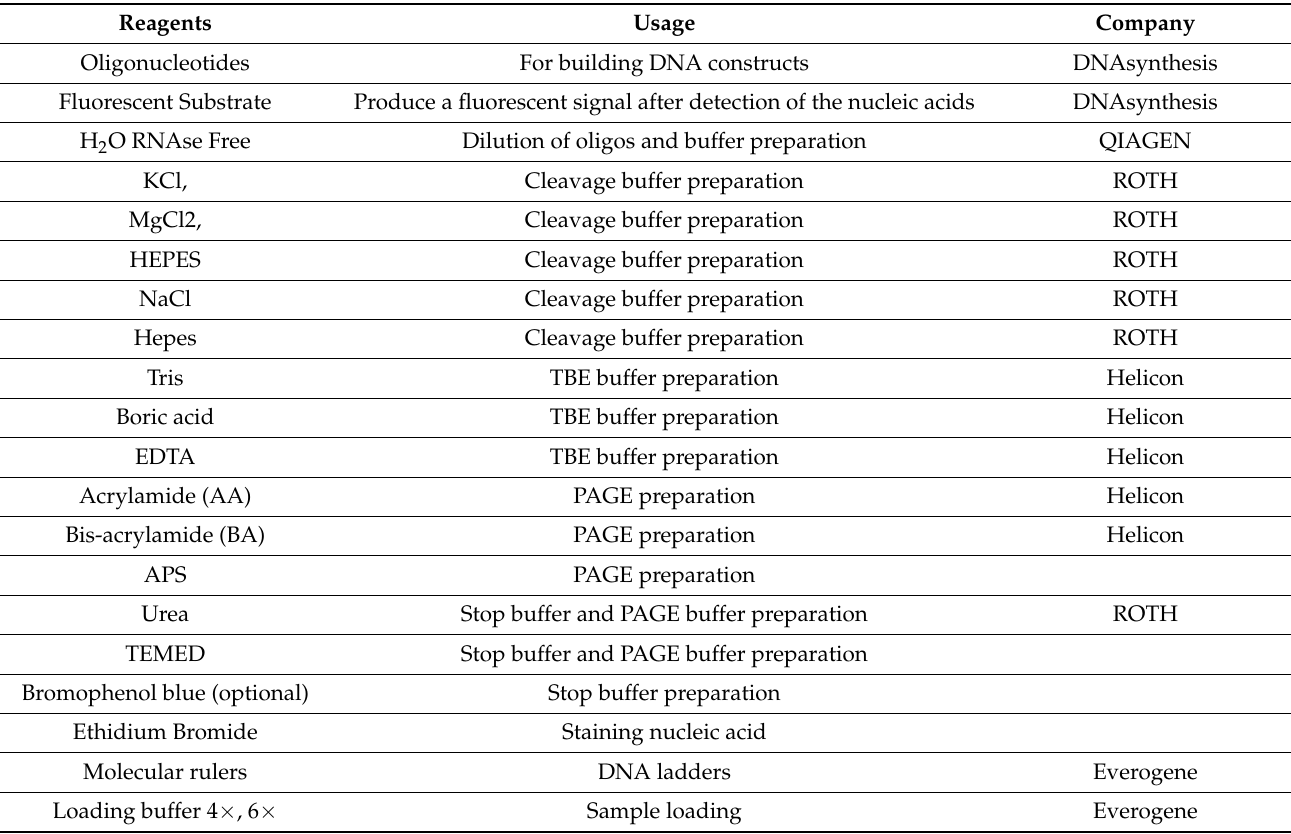
Table 2. Buffers, reagents, and gels used in the